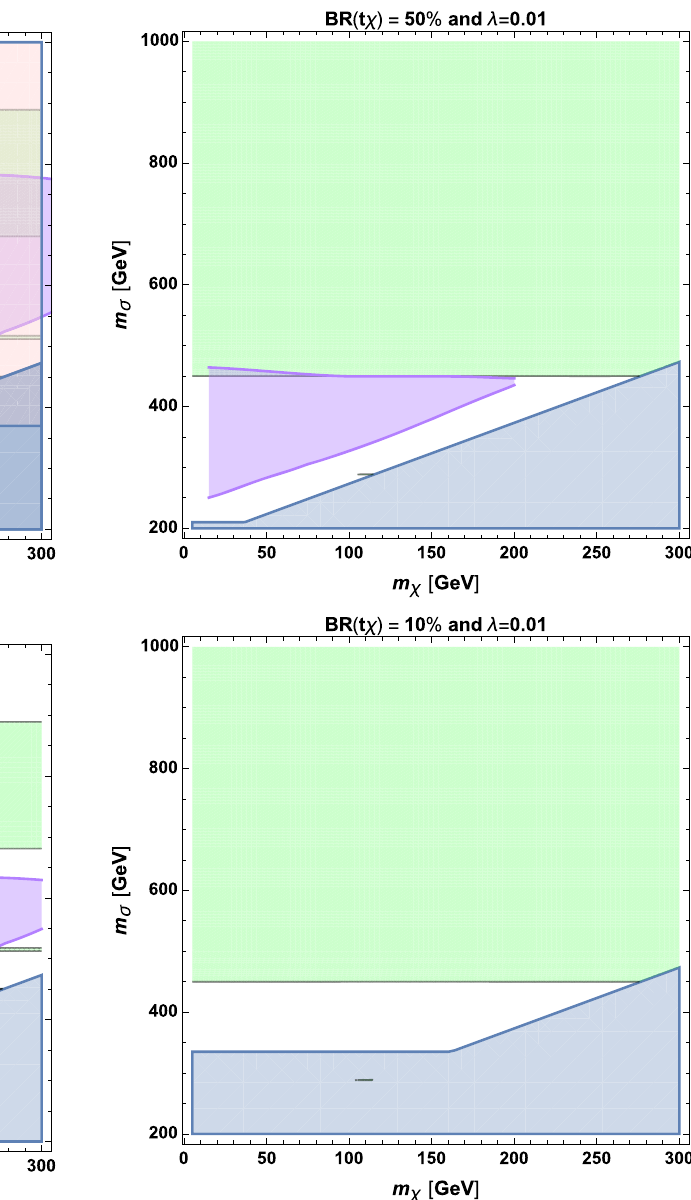
Fig. 10 Current constraints on the parameter space of the considered model featuring resonant monotop production at colliders. The results arepresented in ( m χ , m σ ) planes for various λ andBR t χ 50% and 10%. Whilst the white region are allowed, the coloured areas are excluded by at least one of the bounds described in Sect. 3. We refer to the text for more